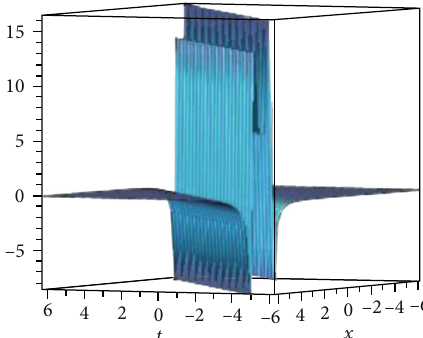
Figure 5: 3D graph of V = 1 , and α = 1 represent traveling wave z 1